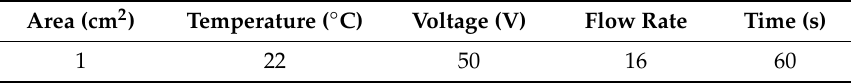
Table 3. Parameters for the electrolytic polish of ferrite rolled IF